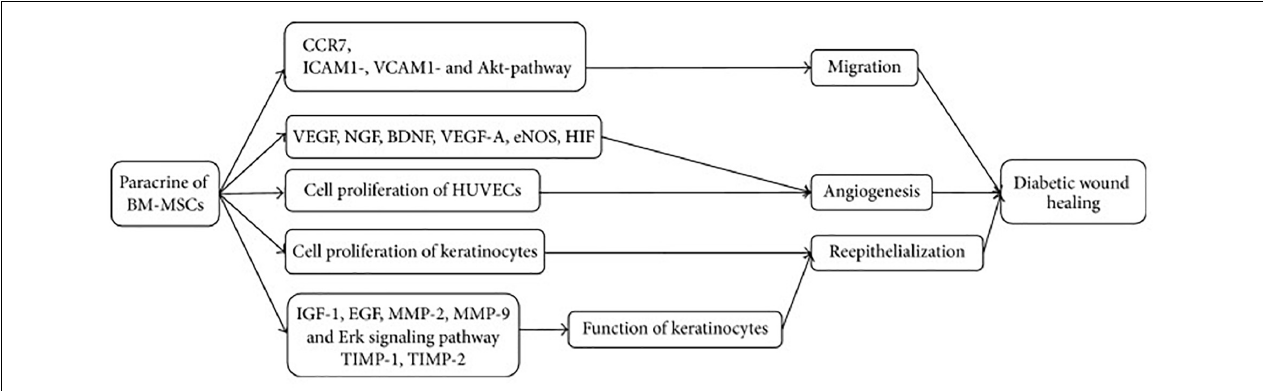
FIGURE 3 | Mechanism of BM-MSCs for treatment of DFU. BM-MSCs can migrate and adhere via CCR7, ICAM1-, VCAM1-, and Akt- dependent mechanism and enhance angiogenesis through increasing VEGF, NGF, BDNF, VEGF-A, eNOS, and HIF. Cell proliferation of HUVECs and keratinocytes plays significant role in angiogenesis and reepithelialization, respectively. Keratinocyte function is improved by regulating IGF-1, EGF, MMP-2, MMP-9, TIMP-1, TIMP-2, and Erk signaling pathway. CCR7, C-C chemokine receptor type 7; ICAM1, intercellular adhesion molecule 1; VCAM1, vascular adhesion molecule 1; VEGF, vascular endothelial growth factor; NGF, nerve growth factor; BDNF, brain-derived neurotrophic factor; VEGF-A, vascular endothelial growth factor A; eNOS, endothelial nitric oxide synthase; HIF, hypoxia inducible factor; IGF-1, insulin-like growth factor 1; EGF, epidermal growth factor; MMP-2, matrix metalloproteinase-2; MMP-9, matrix metalloproteinase-9; TIMP-1, tissue inhibitor of metalloproteinase-1; and TIMP-2, tissue inhibitor of metalloproteinase-2. [Adopted from Cao et al. (2017) distributed under the Creative Commons Attribution